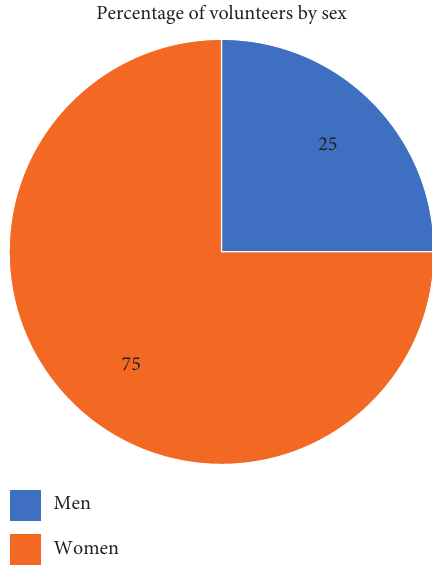
Figure 2: Percentage of the volunteers by sex (source: profile of home care service organizations,